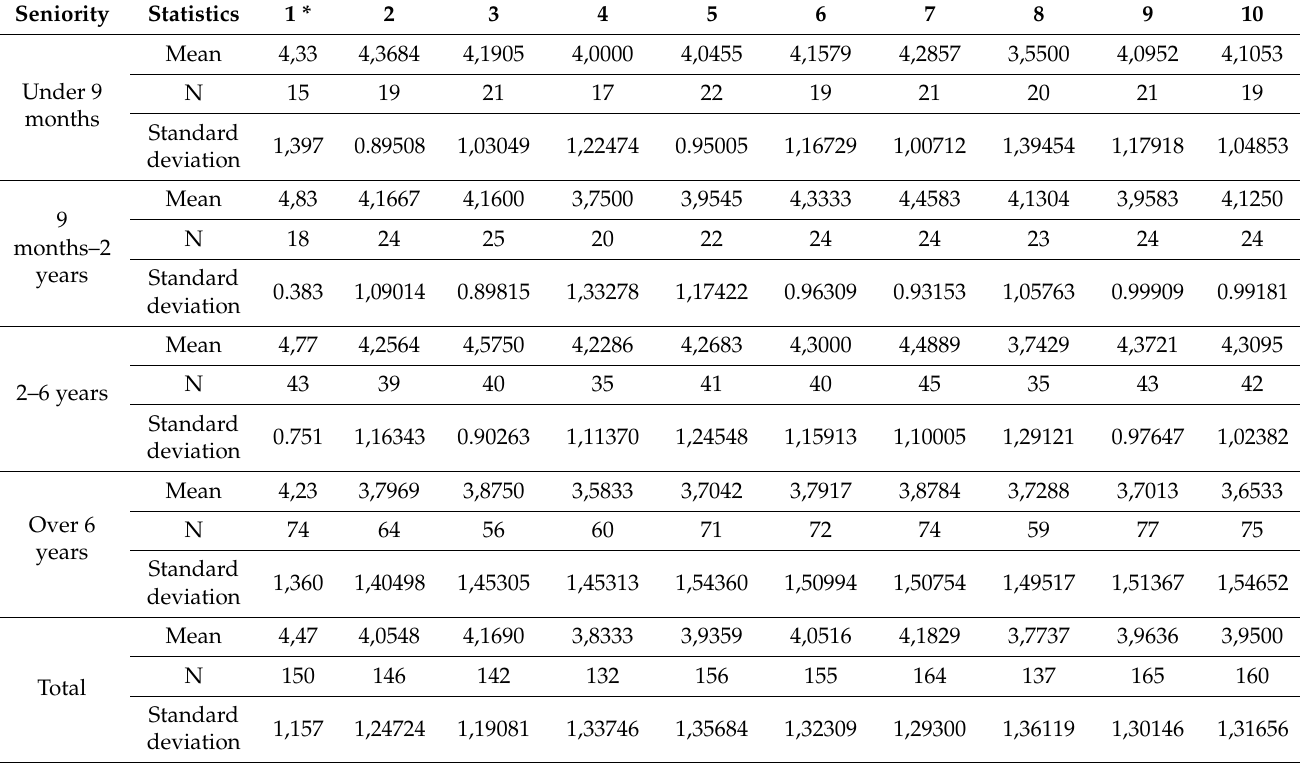
Table 6. Preference for a particular type of onboarding among HR specialists with given seniority.